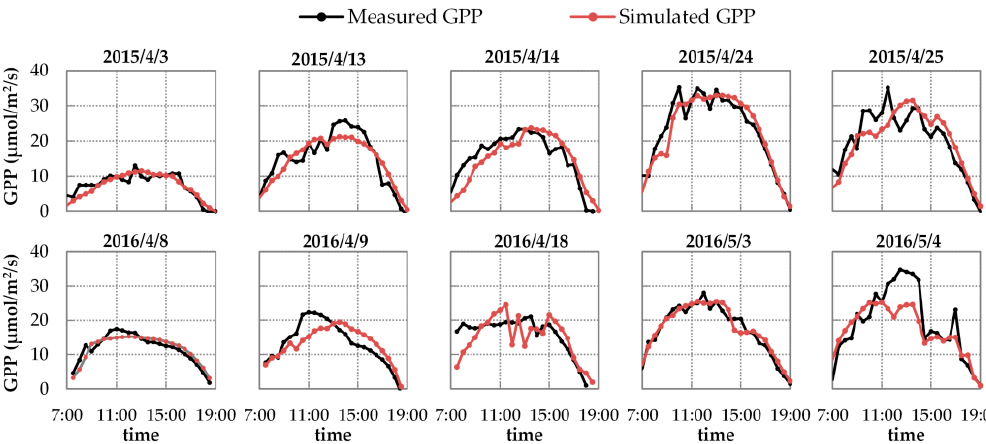
Figure 7. The diurnal cycles of simulated and measured GPP at half-hour intervals between 7:00 and 19:00 on ten fieldwork days in 2015 and 2016.